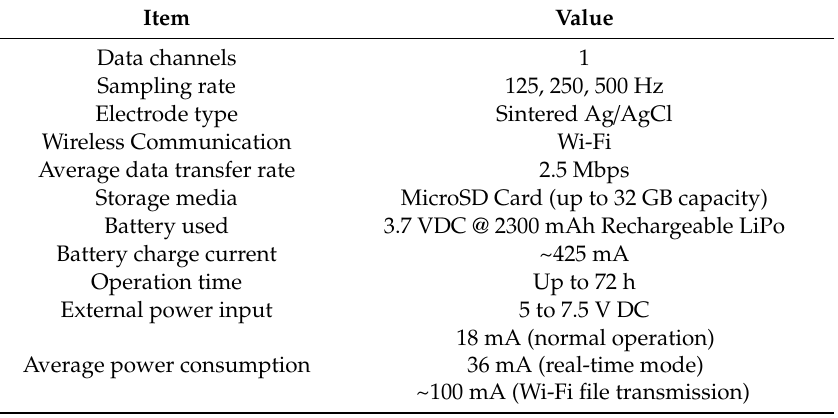
Table 8. Arm-ECG sensor system final prototype main performance specifications